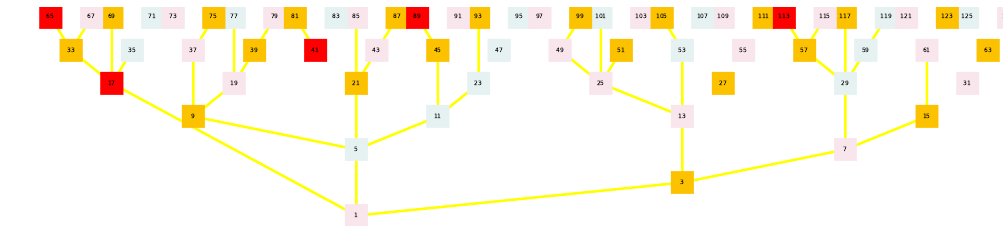
Figure 20. Golden Automaton confined to numbers smaller than 128 [42].